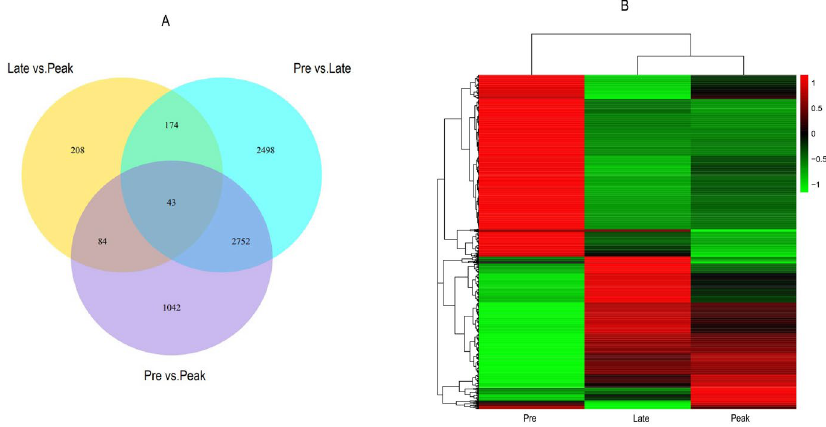
Figure 2. Venn diagram of the three comparisons of the differentially expressed genes ( A ). Hierar- chical clustering analysis of the DEGs in the three comparisons ( B ).